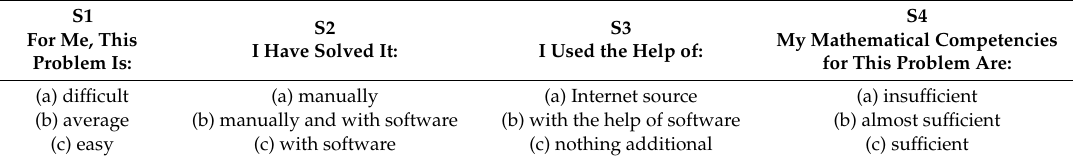
Table 1. Survey sheet for each problem in the test.